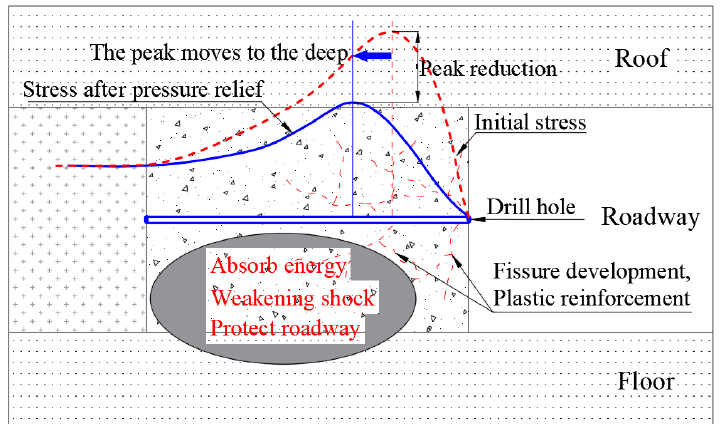
Figure 16. Borehole pressure relief